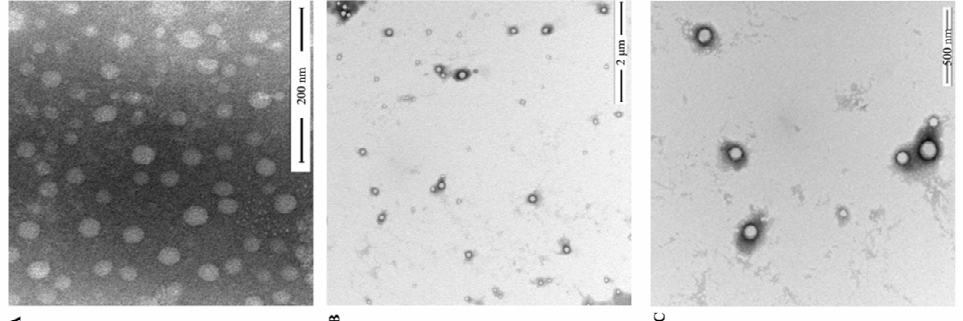
Figure 2. TEM images of RES-loaded PLGA-NPs ( A ); PCAC-NPs under 2 µ m field of view ( B ) and 500 nm field of view ( C ).